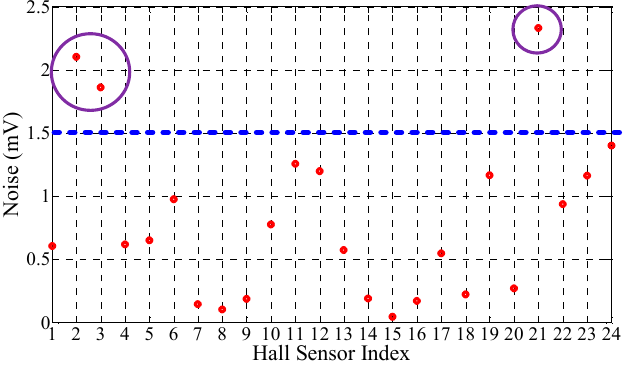
Figure 2. Noise measurement from each Hall sensor.